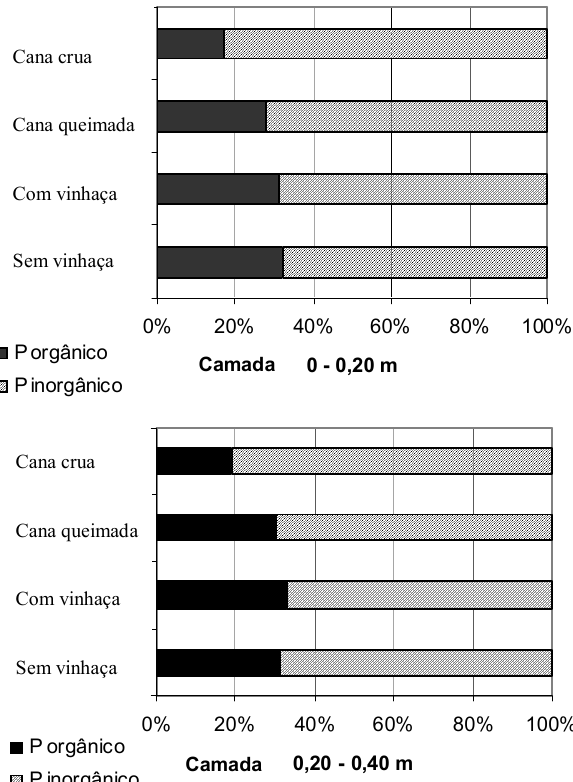
Figura 2. Distribuição relativa de P orgânico e inorgânico de um Cambissolo Háplico Ta eutrófico vértico da região Norte Fluminense submetido ao cultivo de cana-de-açúcar sob diferentes sistemas de